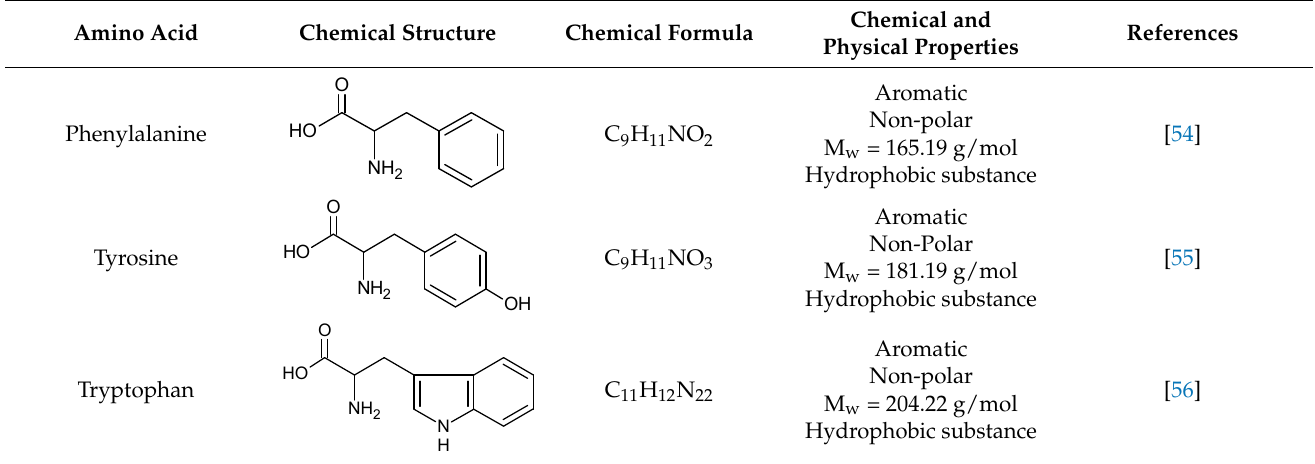
Table 1. Chemical structure and physical-chemical properties of AAs: Phe, Tyr, and Trypt. Amino Acid